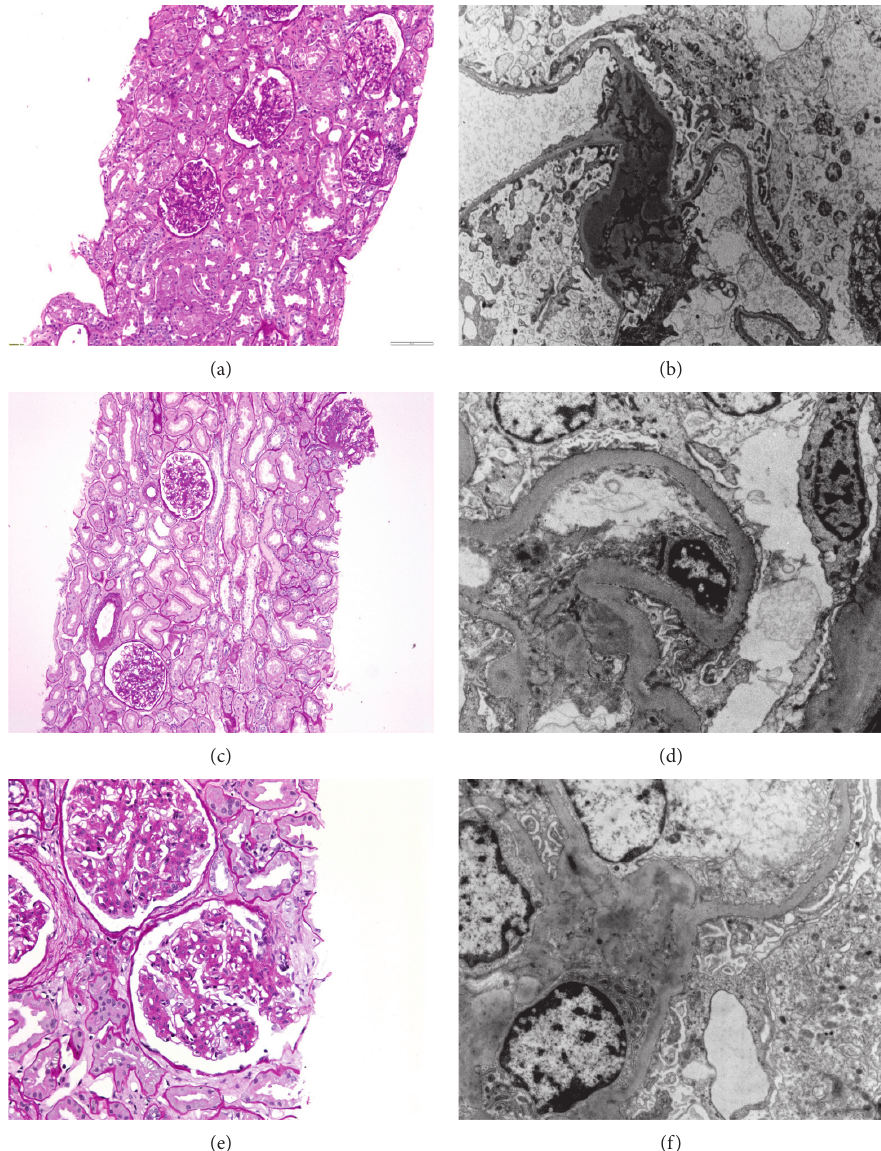
Figure 1: Kidney pathology of three cases. Case 1: (a) glomeruls with normal appearance (PSA stain × 100); (b) diffuse mesangial immune deposits (electron microscopy × 2800). Case 2: (c) one glomeruls with perihilar segmental sclerosis (PSA stain × 100); (d) mesangial immune deposits (electron microscopy × 5600). Case 3: (e) glomeruls with diffuse mesangial hypercellularity (PSA stain × 200); (f) mesangial immune deposits (electron microscopy ×